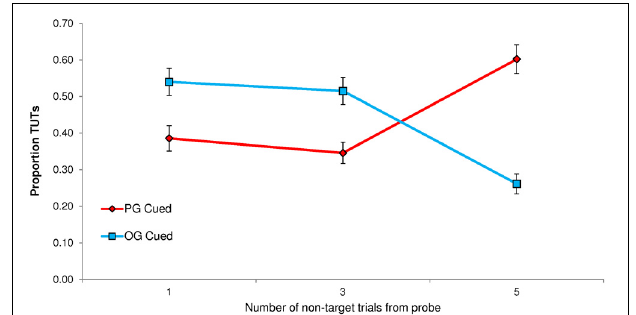
FIGURE 1 | Proportion of task-unrelated thoughts (TUTs) in the Sustained Attention to Response Task following personal-goal (PG) cues and other-goal (OG) cues, for Experiments 1–4 (E1–E4) individually, for the full dataset combined across experiments, and for the first appearance only of each PG and OG cue combined across experiments. Error bars represent standard errors.